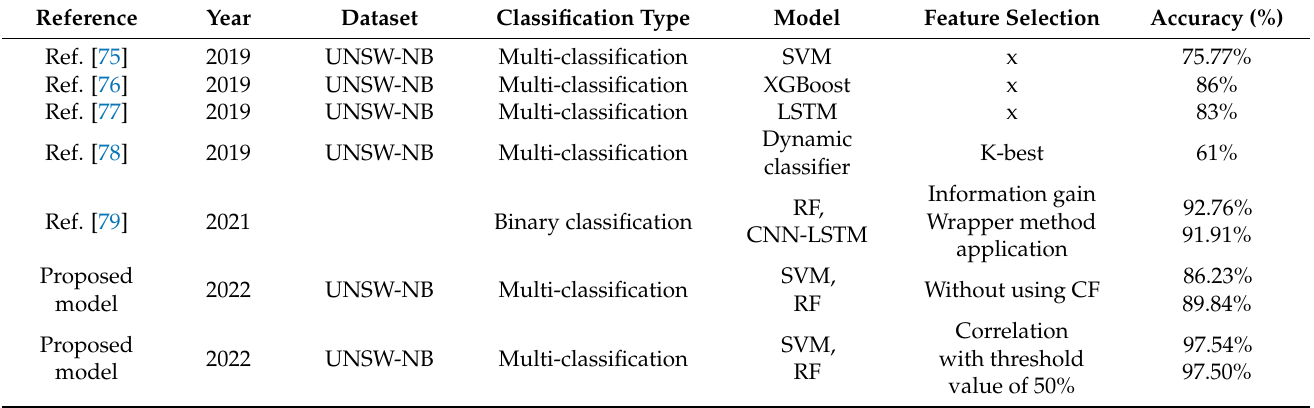
Table 12. Results of the proposed system against existing security systems using the same